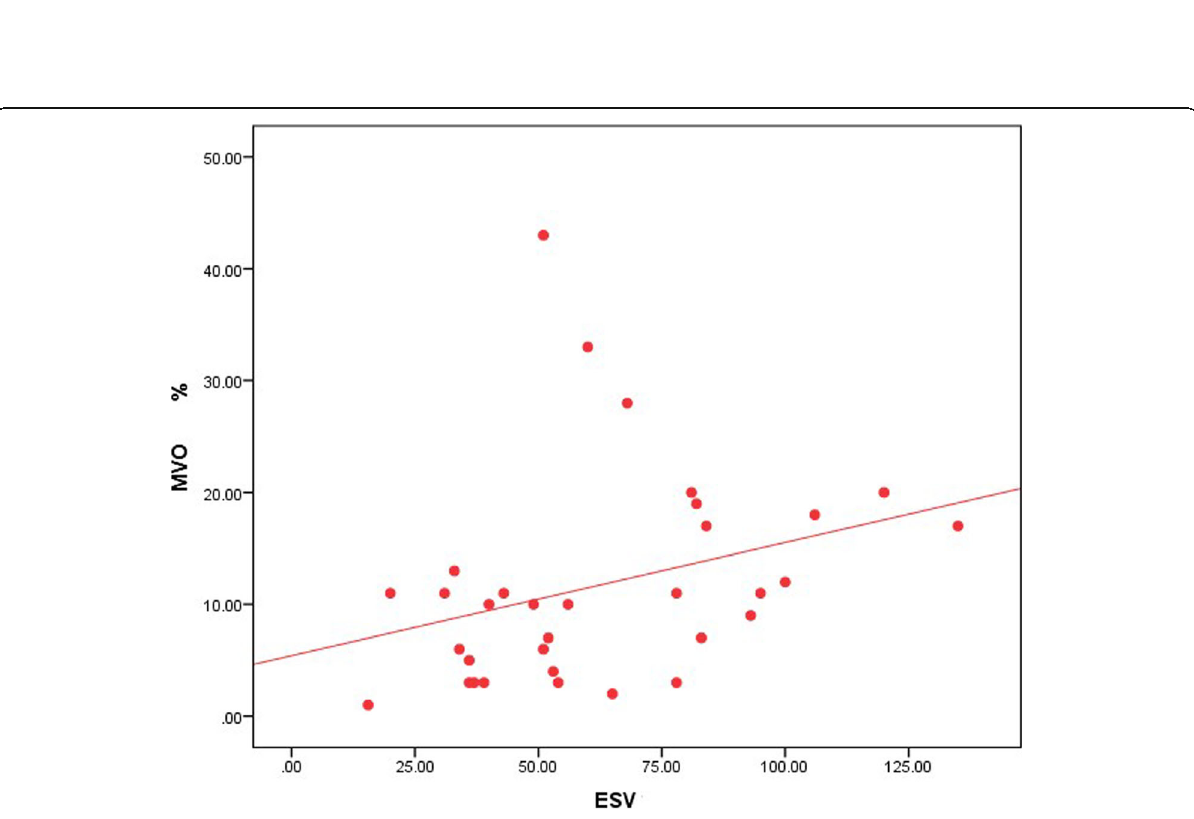
Fig. 5 A scatter plot matrix showing a significant a positive correlation between MVO size % and LV ESVI measured at the 2nd visit